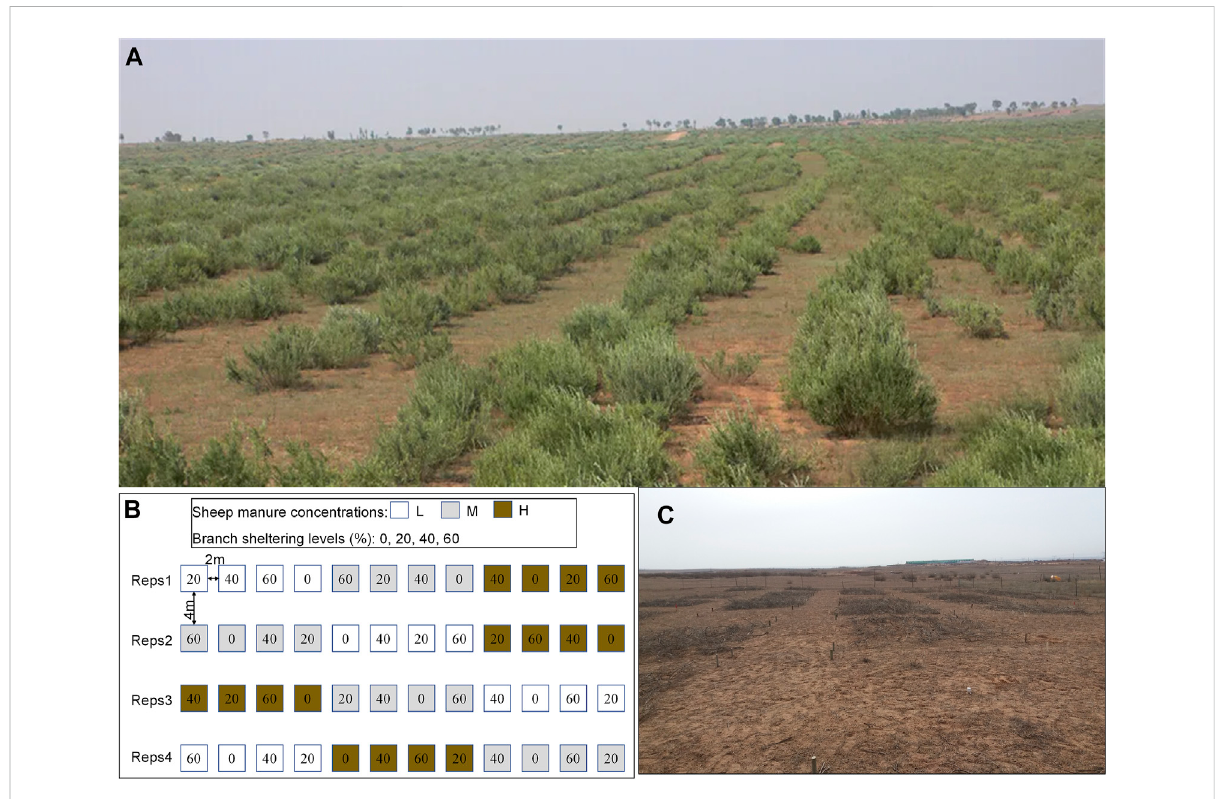
FIGURE 1 Shrubencroachedgrassland (A) instudysiteandschematic (B) andphoto (C) showinglayoutoftheexperimentalstudysiteandplots.L,MandH in fi gure b are low, medium, and high amount of manure accumulated in grassland